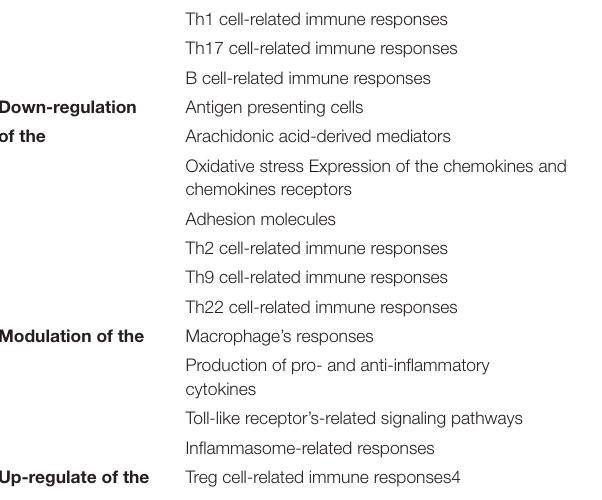
TABLE 4 | The anti-inflammatory, antioxidant activities and immunomodulatory effects of ginger and its